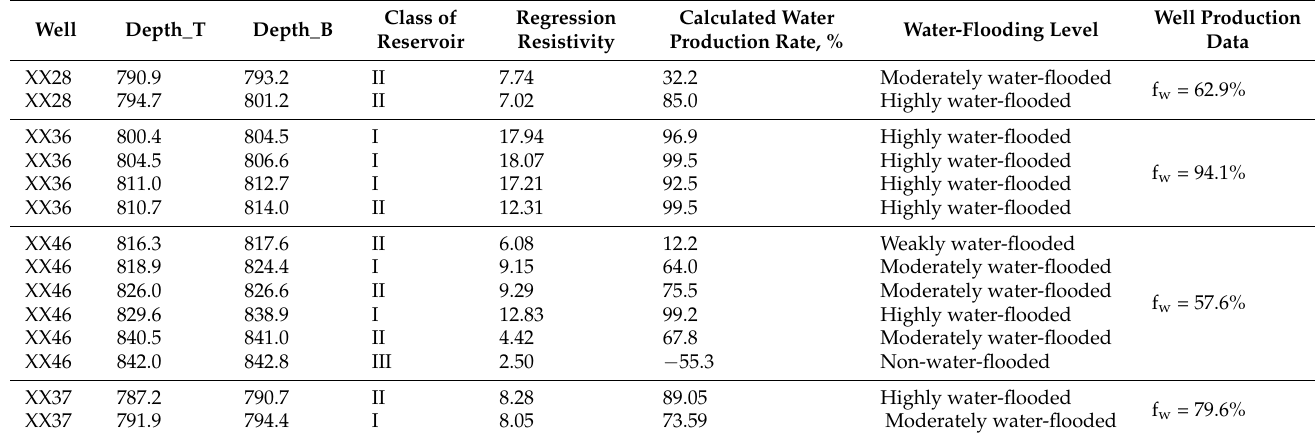
Table 6. Interpretation results of some new wells in the P